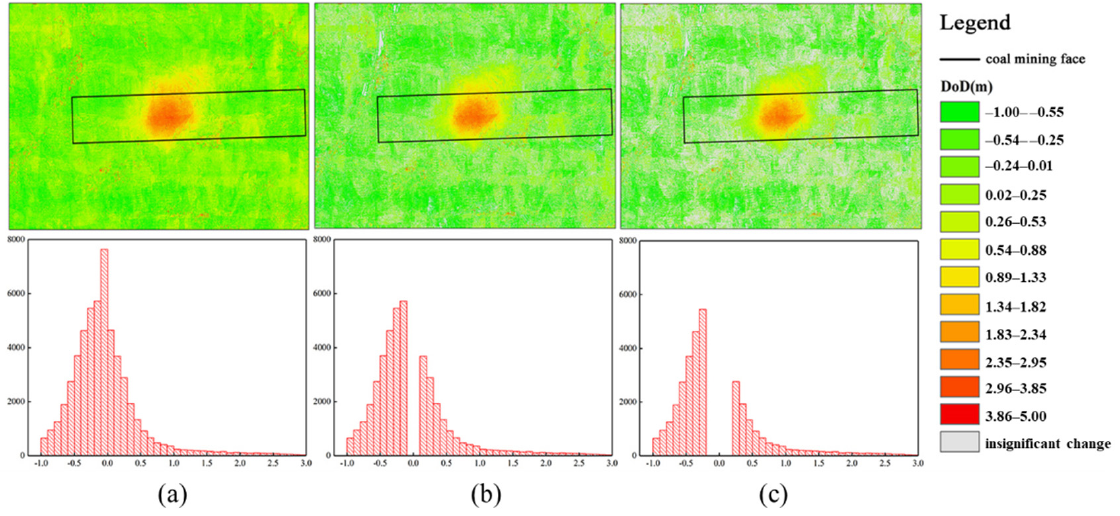
Figure 9. MinLoD threshold assessment of the significance for the variability in the DoD elevation: ( a ) minlod = 0.00 m; ( b ) minlod = 0.10 m; and ( c ) minlod = 0.20 m. ( a ) minlod = 0.00 m; ( b ) minlod = 0.10 m; and ( c ) minlod = 0.20